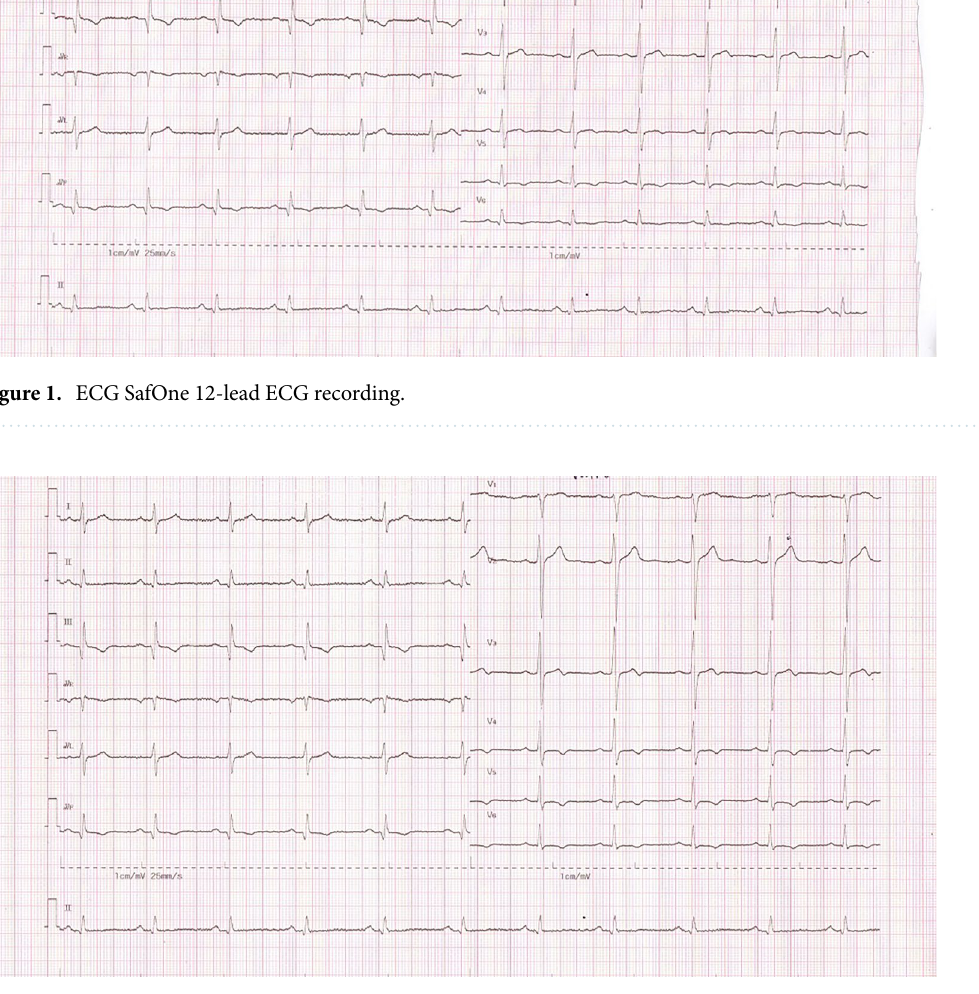
Figure 2. Standard ECG 12-lead ECG recording.